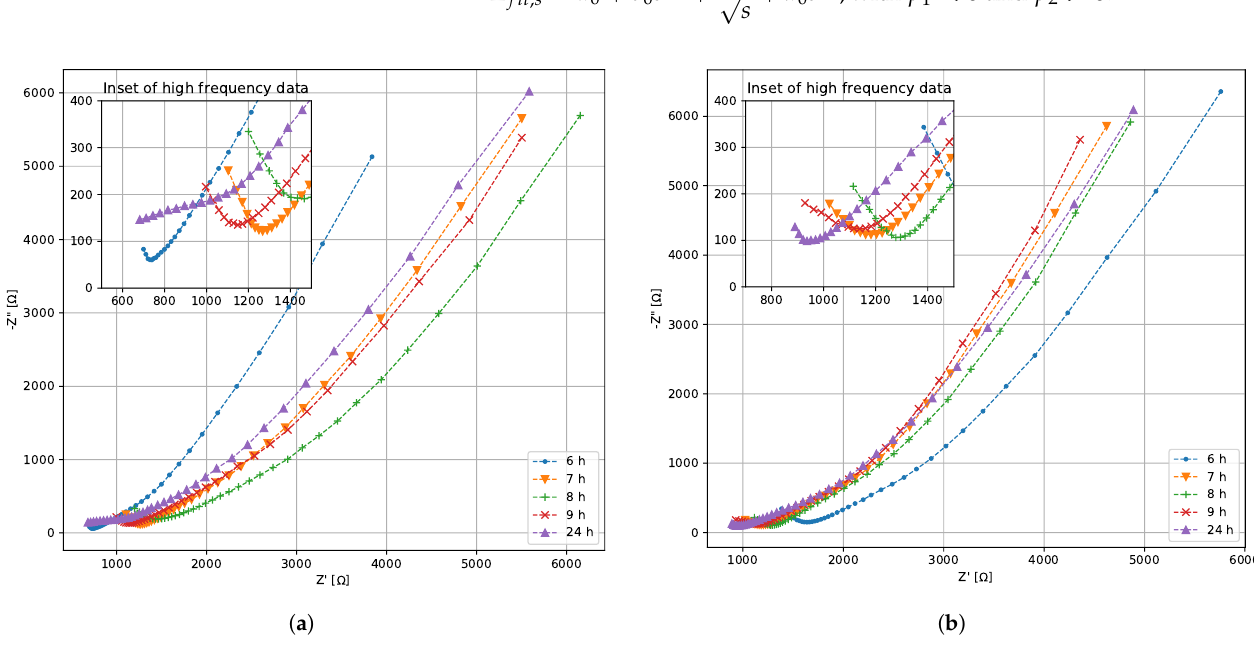
Figure 6. Nyquist plots of the EIS data for P. bifermentans ( a ) without and ( b ) with Pb(II). After fitting Equation (8) on all the hourly data sets gathered for both K. pneumoniae and P. bifermentans , it was discovered that the powers p 1 and p 2 settle very close to the same value in every case. The values for these parameters were then fixed to p 1 = − 1.5 and p 2 = 1, which correspond to the electrical performance of a fractional power supercapacitor and an inductor, respectively. The former of these may correspond to the proliferation of cells in the solution, while the most likely explanation for the latter is the inductance caused by the wires connecting the sensing electrode to the device used to perform the EIS. The final function used for fitting data is